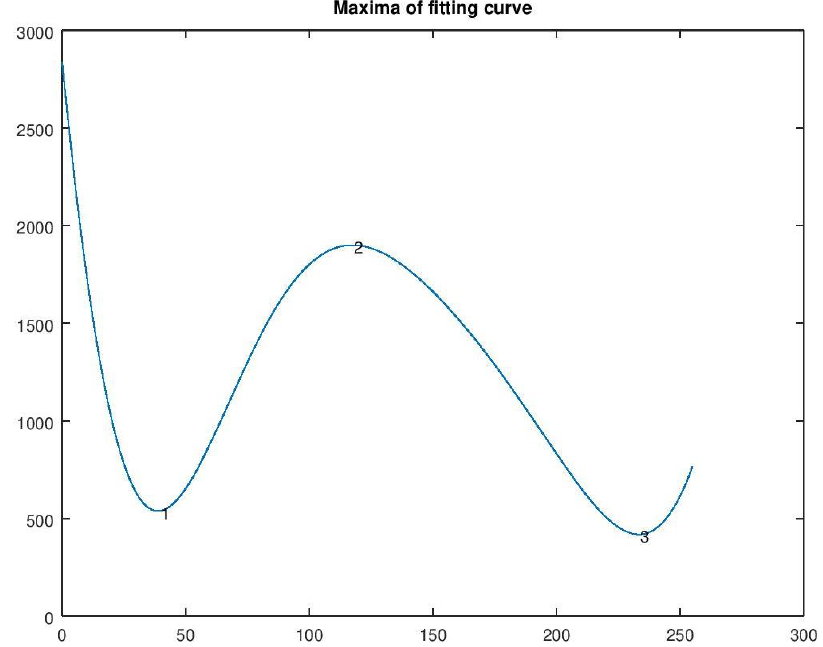
Figure 14. Maxima and minima of the polynomial curve.